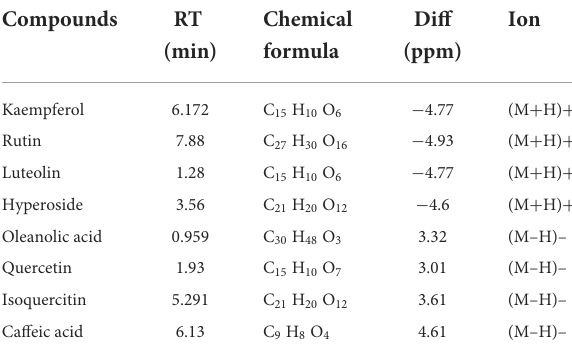
TABLE 2 The active compounds identified from SOL